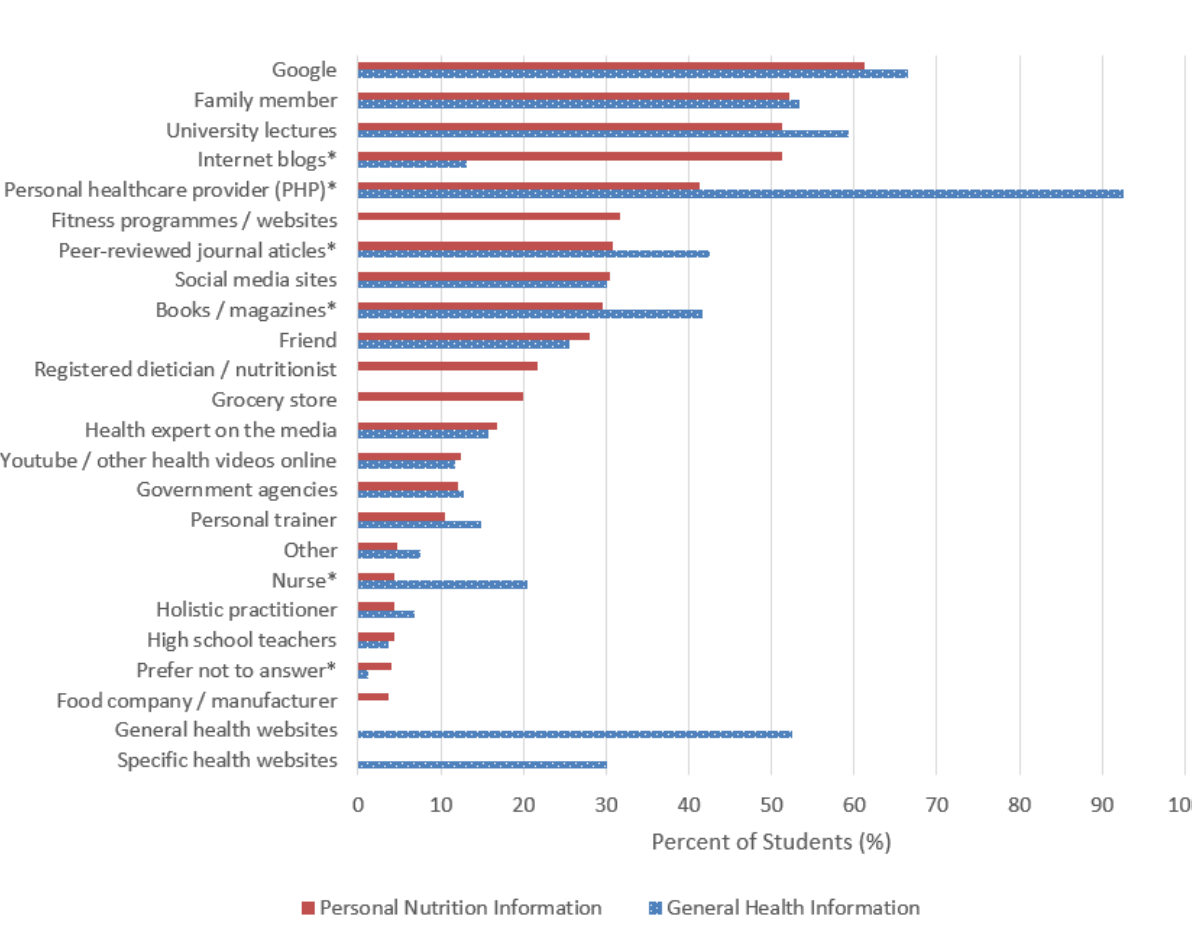
Figure 1. Primary sources of information utilised for general health and personal nutrition needs by first year Canadian and US veterinary students (n=322) retrieved from questionnaire that assessed health attitudes and behaviours. Students could select more than one response option for these questions (*p <0.05, derived from Mann-Whitney Rank Sum